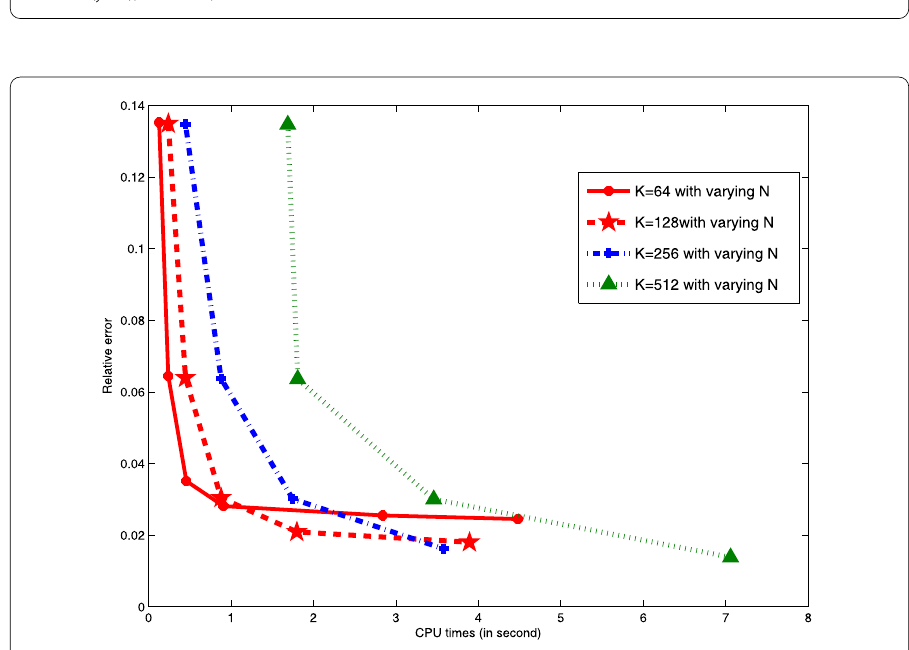
Figure 4 CPU VS Accuracy. Model parameters are σ = 0.4, r = 0.06, D = 0.02, T – t = 1(year), E = $25, X = 100